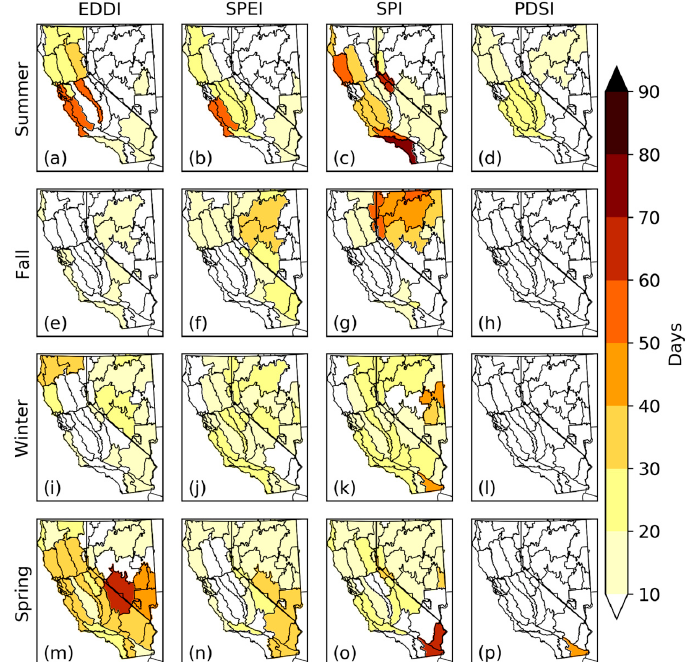
Figure 5. Lag (in days) at which the maximum correlation (highest R 2 ) is found between each of the four drought indices and the 1000-hr fuel moisture fire-danger output, broken down by season and by PSA across California and Nevada. Drought indices include ( a,e,i,m ) EDDI, ( b,f,j,n ) SPEI, ( c,g,k,o ) SPI, and ( d,h,l,p ) PDSI and seasons include ( a,b,c,d ) summer, ( e,f,g,h ) fall, ( i,j,k,l ) winter, and ( m,n,o,p ) spring.